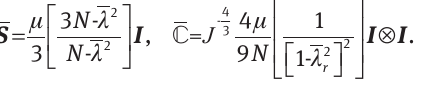
inverse Langevin function in the free energy yield better